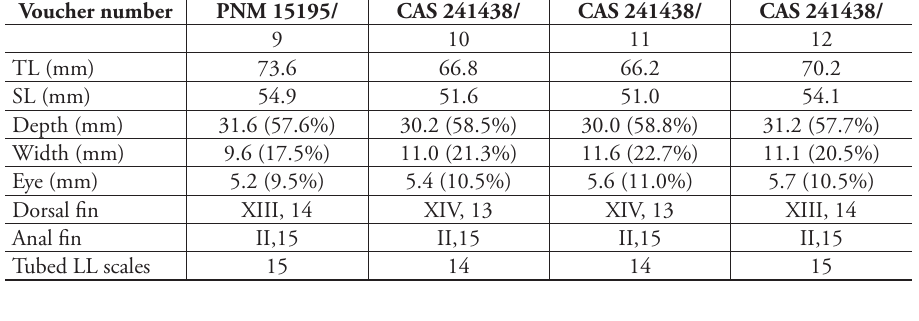
Table 1. Morphometric and Meristic measurements of Altrichthys . Lines present, from top to bottom, numbers for Total Length (TL), Standard Length (SL), Depth, With, Eye Diameter (Eye), spine and ray counts for Dorsal and Anal fins, and Tubed Lateral Line Scales (Tubed LL scales). Number in parenthesis represent percentage of the Standard length). The first column is the species holotype.